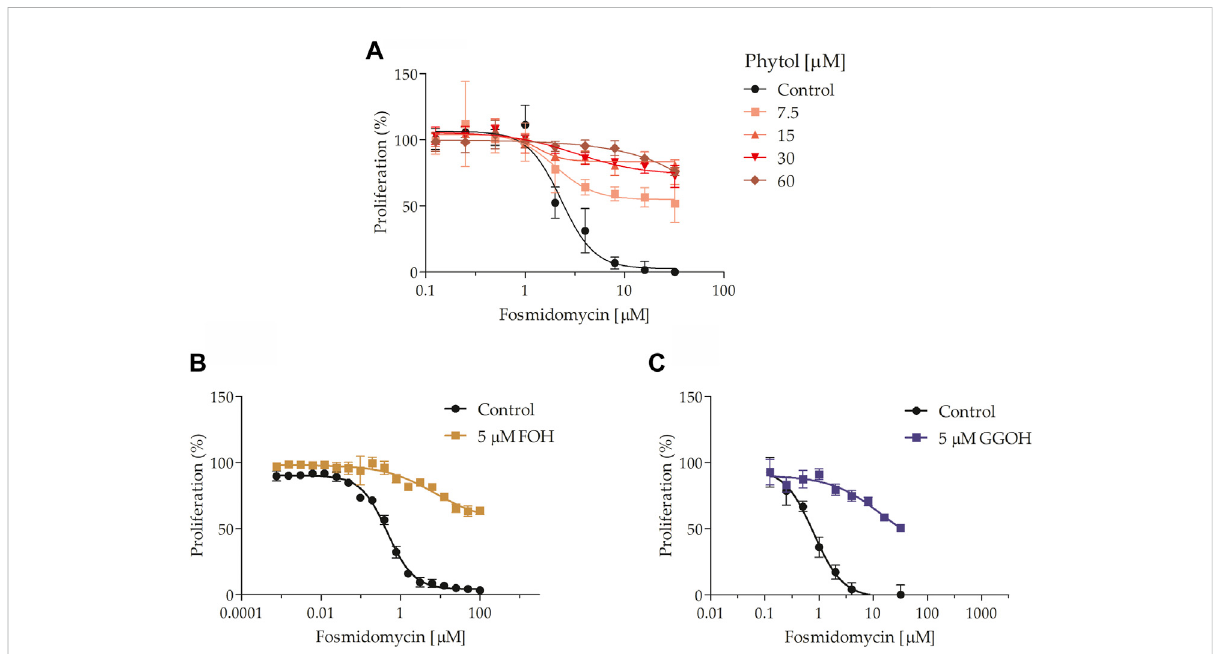
FIGURE 6 Fosmidomycin-rescue assays using isoprenoid alcohols. It was studied the fosmidomycin dose-response effect at 48 h in the presence or absence of 7.5, 15,30, or 60 μ MPOH (A) ,5 μ MFOH (B) , and 5 μ MGGOH (C) . Fosmidomycin IC 50 wascalculated in (A) 1.903 ± 0.519 µM, (B) 1.220 ± 0.604 µMand (C) 1.250±0.438 µM.Thevaluerepresentsthemean±SDfromthreeindependentassays.StatisticalanalysiswasperformedwithOne Way ANOVA, followed by the Tukey posttest (*** p < 0 .005 in relation to control).